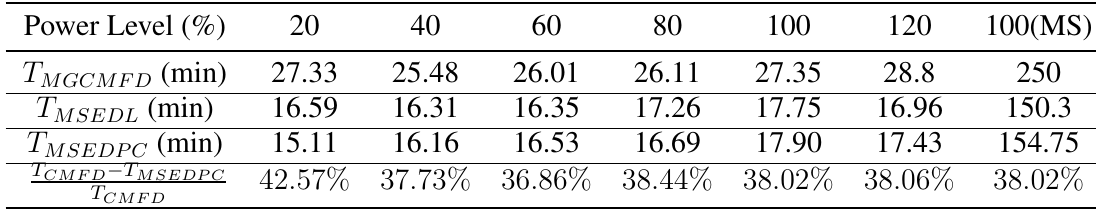
Table 6: Run Time for Problem